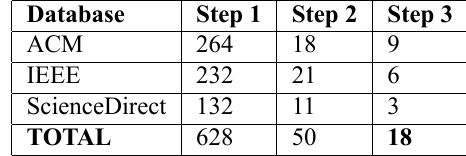
Table 1. Number of papers selected at each stage of the